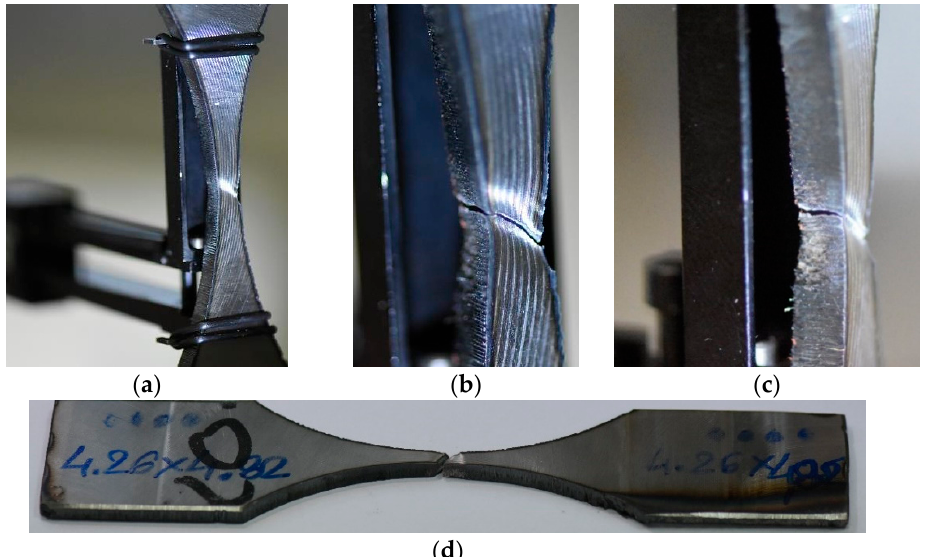
Figure 6. Tensile characteristics and mechanical parameters of the Hardox 450 MAG weld.